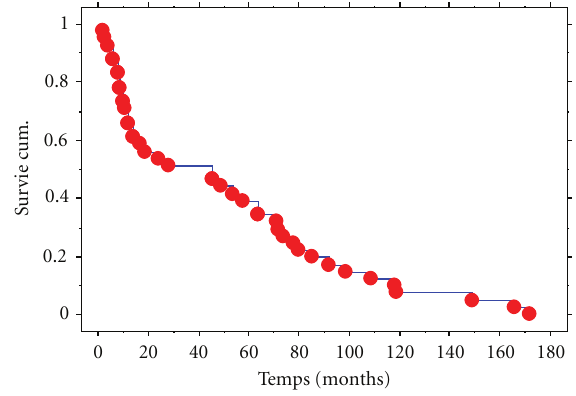
Figure 1: Overall survival curve of the patients with DLBCL. Kaplan-Meier Graphe de Survie Cum. Pour Colonne 1 Variable censure: < Sans > . Table 3: Biological characteristics of